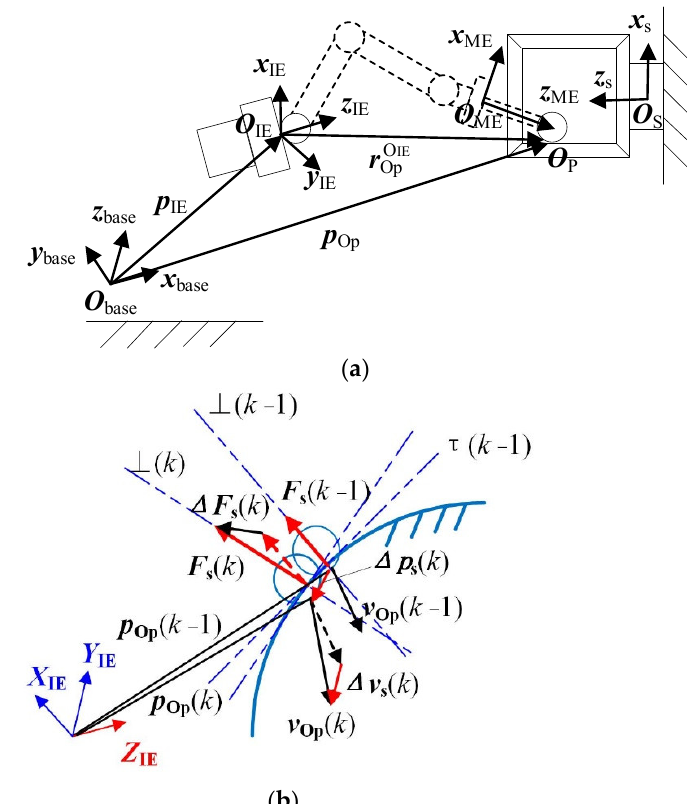
Figure 8. Description of contact process. ( a ) Position of contact point. ( b ) Velocity and force at contact point.